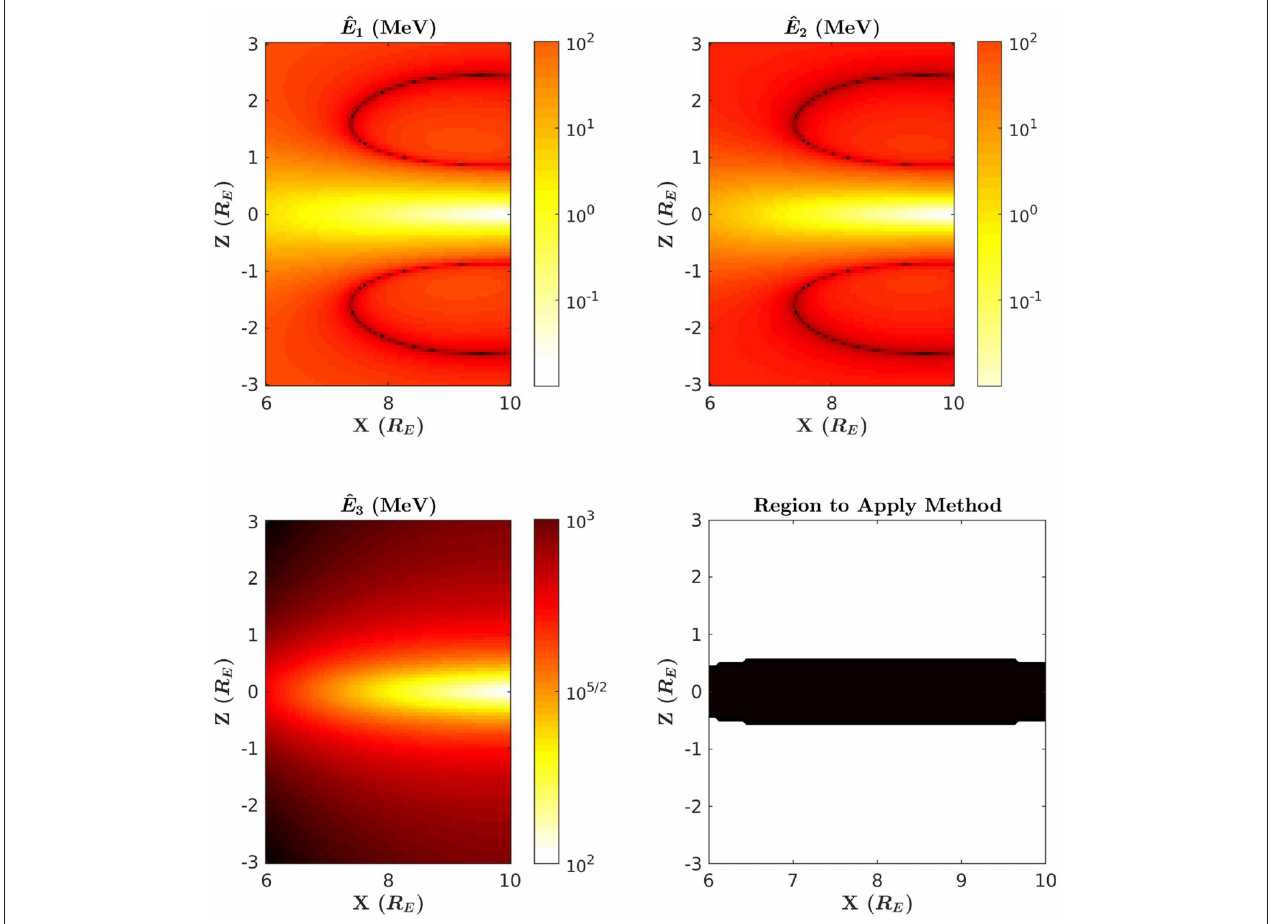
FIGURE 3 | ˆ E 1 , ˆ E 2 , and ˆ E 3 computed over midnight local time in the case of K p = 5. Bright colors indicate lower energy, and darker colors indicate higher energy. ˆ E 1 is shown in the top left panel, ˆ E 2 in the top right, and ˆ E 3 in the bottom left. In the bottom right panel, the region where this method should be applied is shown in